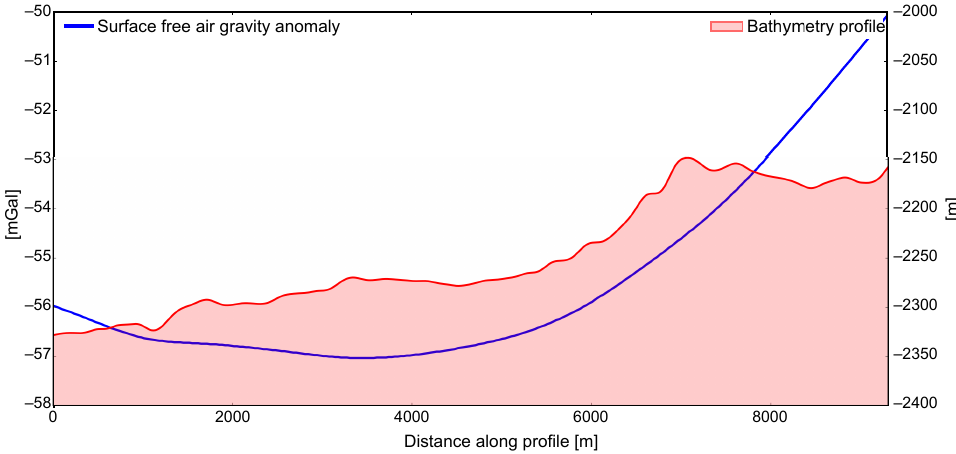
Figure 10. Depth of the underwater relief and surface free air gravity anomaly both provided by the SHOM as a function of distance travelled along the studied